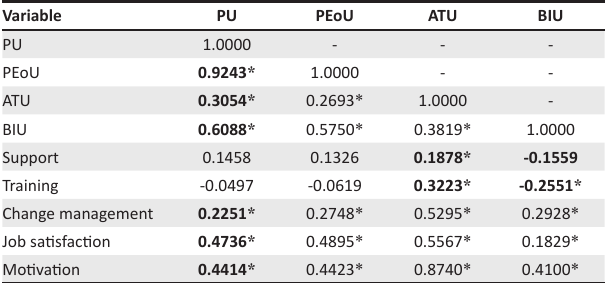
TABLE 4: Correlation between perceived usefulness, perceived ease of use and independent variables. Variable PU PEoU ATU